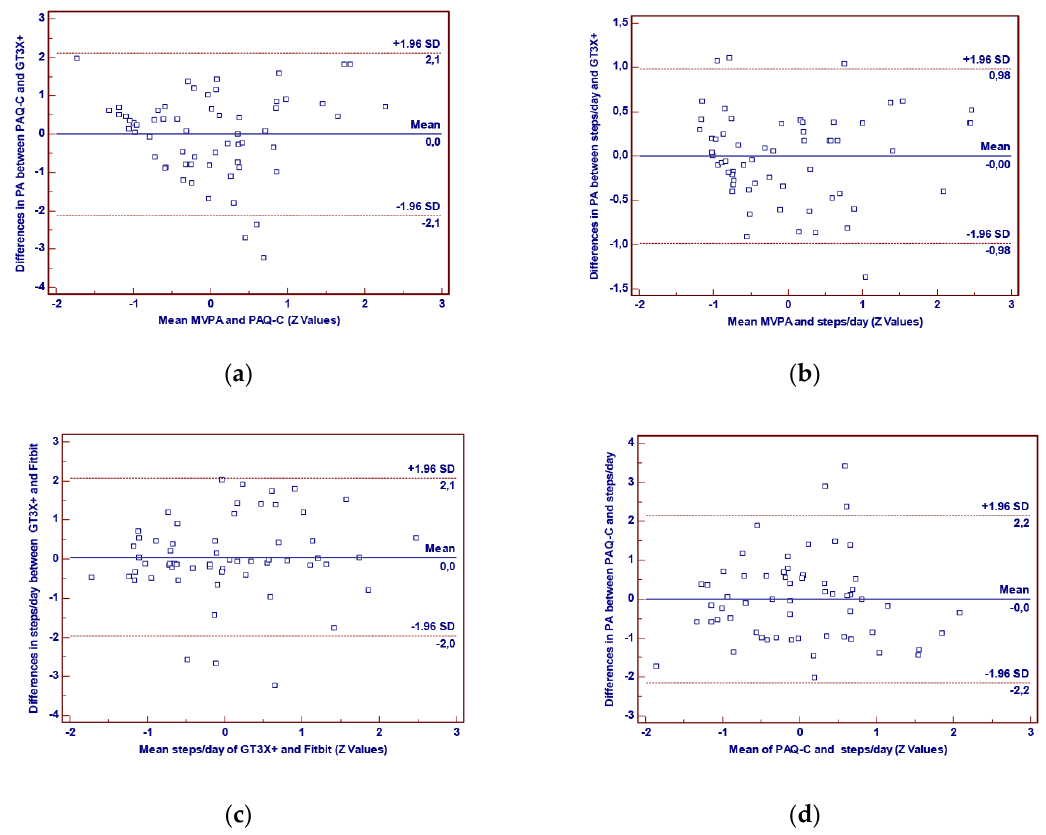
Figure 1. Bland–Altman plots with differences for ( a ) PAQ-C total score and MVPA, ( b ) Flex-2 steps/day and MVPA, ( c ) steps/day of GT3X+ and steps/day of Flex-2, ( d ) PAQ-C total score and Flex-2 steps/day.